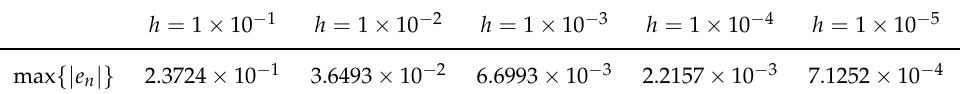
Table 2. Numerical results (silkworm population model).